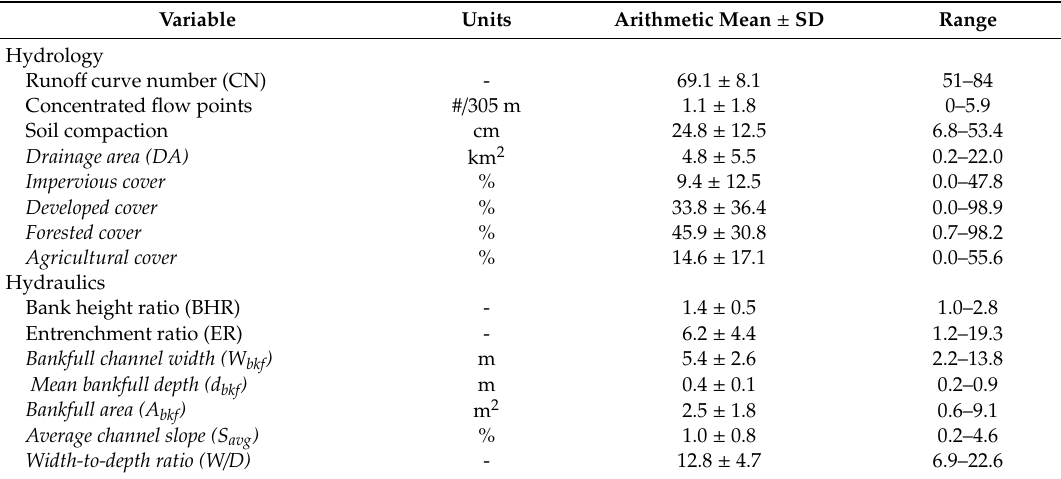
Table 2. Summary of data for 34 Piedmont stream sites. Italicized variables are additional variables, not included in the SQT